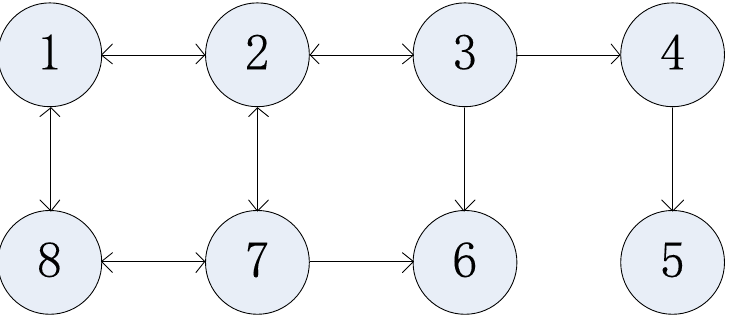
Figure 1. The topology graph G with 8